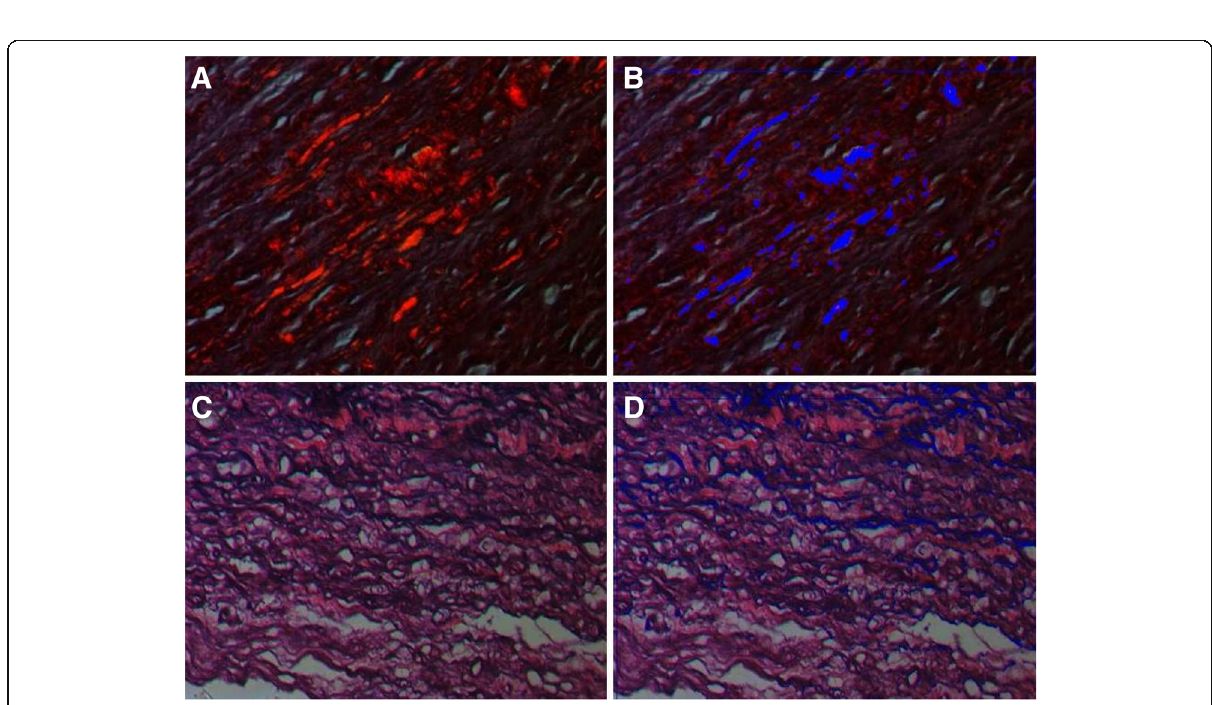
Fig. 2 a Histological section stained with picrosirius seen under polarized light, 1250x final increase, evidencing a greater amount of birefringent collagen fibers. b Quantification of collagen fibers, stained by picrosirius by Leica Qwin Plus® software, evidenced by the blue area. c Histological section stained with verhoeff seen under common light, 1250x final increase, showing a greater amount of elastic fibers, evidenced by the blackened coloration. d Quantification of elastic fibers, stained by verhoeff by Leica Qwin Plus® software, evidenced by the blue area